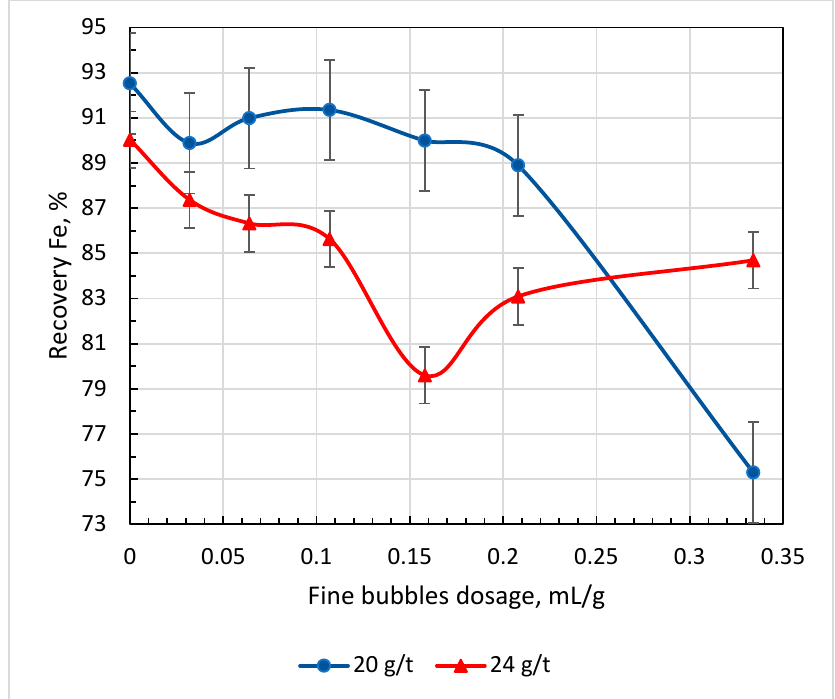
Figure 5. Dependence of iron recovery on fine bubble dosage at the CTAB dosage of 20 and 24 g/t. Treatment time—7.5 s; TFR diameter—6 mm. (Error bars represent the standard deviation obtained from 3 test repeats).